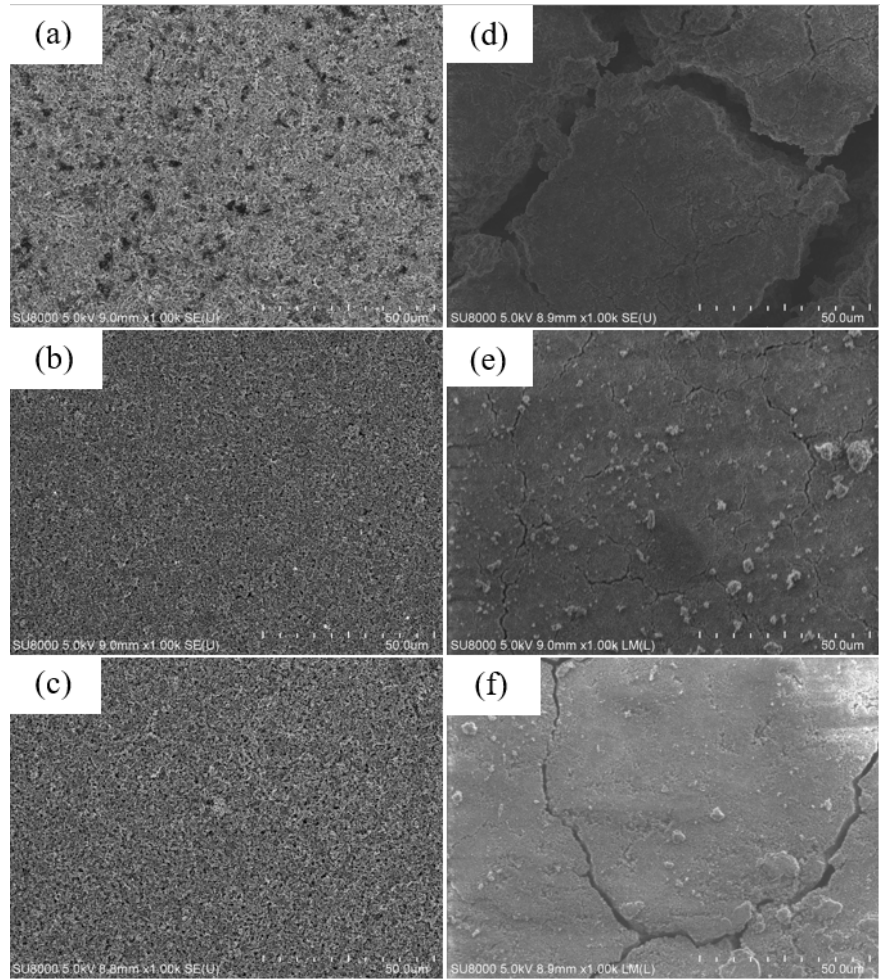
Figure 14. SEM images of ( a , d ) anode made of silicon flakes–KB–CMC/SBR = 70%:10%:20% in weight ratio, ( b , e ) pyrolytic anode made of silicon flakes–KB–CMC/SBR = 70%:10%:20% in weight ratio, ( c , f ) pyrolytic anode made of silicon flakes–CMC/SBR = 70%:30% in weight ratio ( a – c ) before, and ( d – f ) after 200 discharge–charge cycles.